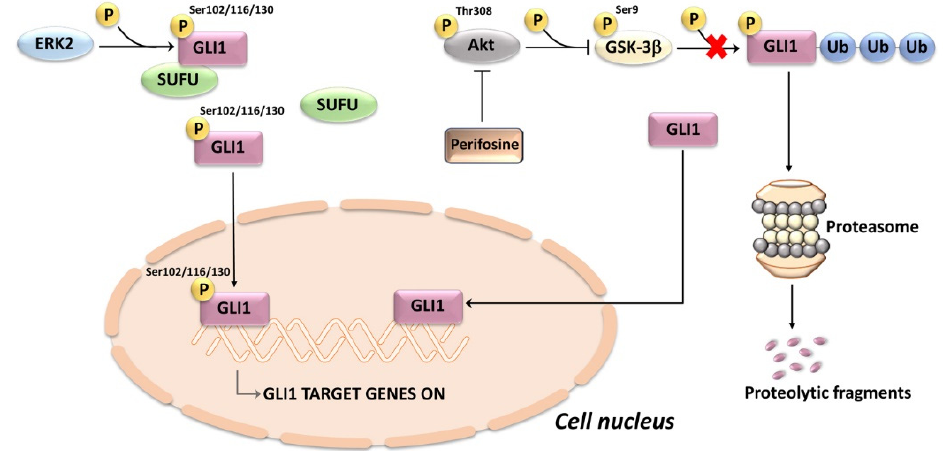
Figure 4. ERK2 and Akt upregulate the transcriptional activity of GLI1 in T-ALL cells. The schematic cartoon illustrates possible mechanisms of GLI1 activation through ERK2 and Akt signaling. ERK2 phosphorylates GLI1 at Ser residues, thereby loosening the interactions between SUFU and GLI1 which is free to translocate to the nucleus. Active (Thr 308 phosphorylated) Akt phosphorylates GSK-3 β at Ser 9, thereby inhibiting GSK-3 β which cannot target GLI1 for ubiquitination and proteasomal degradation. The Akt inhibitor perifosine restores GLI1 proteolysis. GSK-3 β , glycogen synthase kinase 3 β ; SUFU, suppressor of fused.